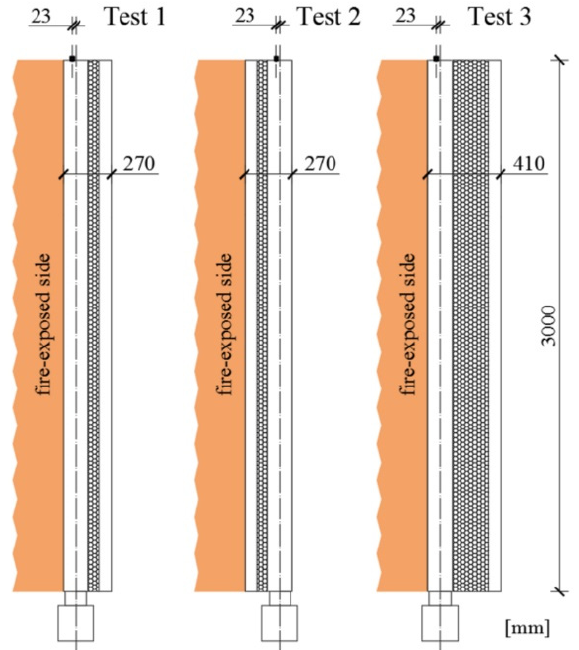
Figure 3. Vertical test set-up and location of the eccentric vertical loading.